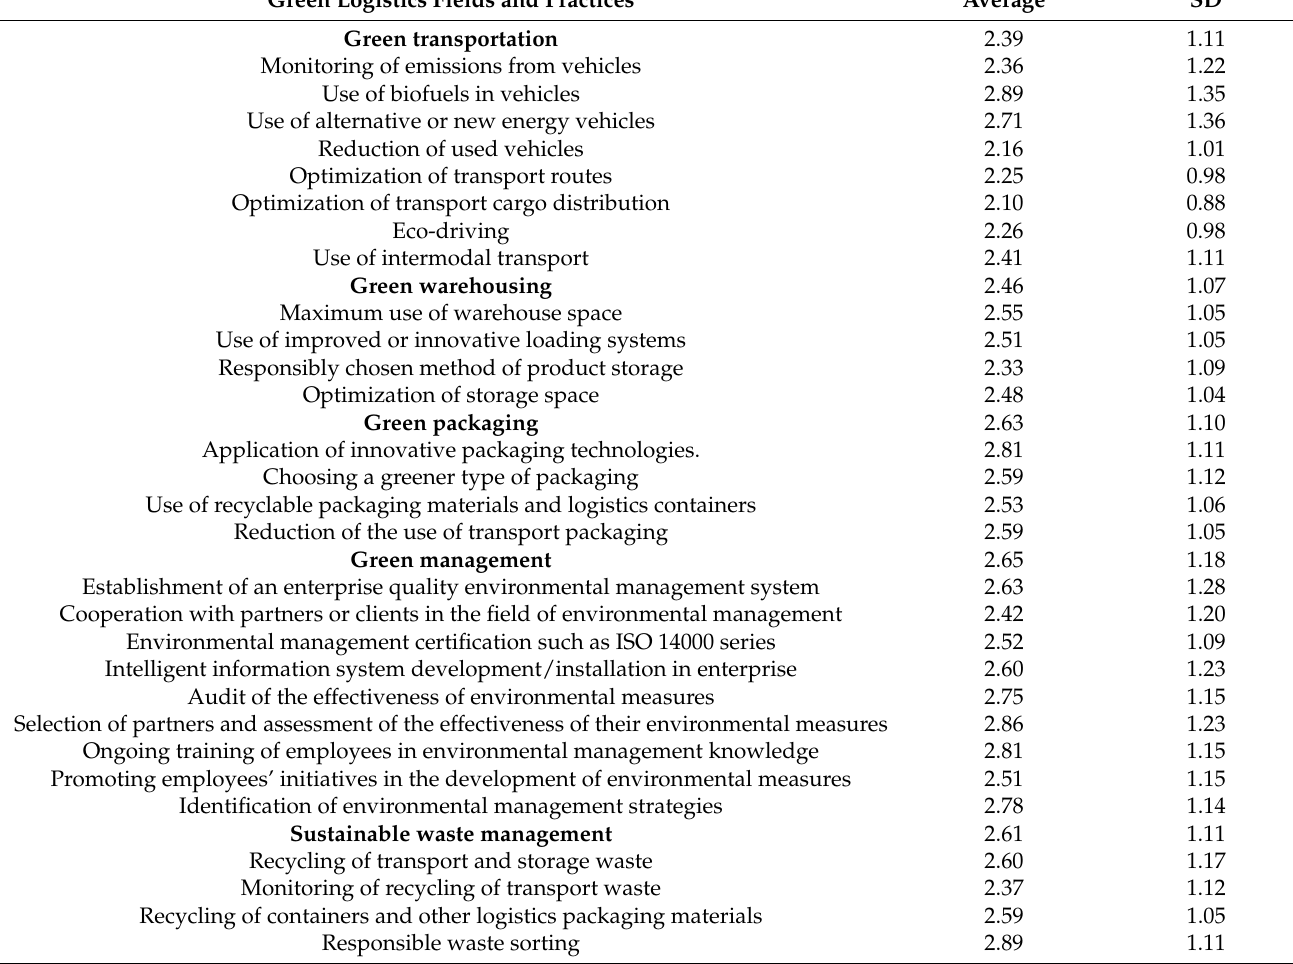
Table 3. GL fields and practices in Lithuanian transport and logistics companies ( n =